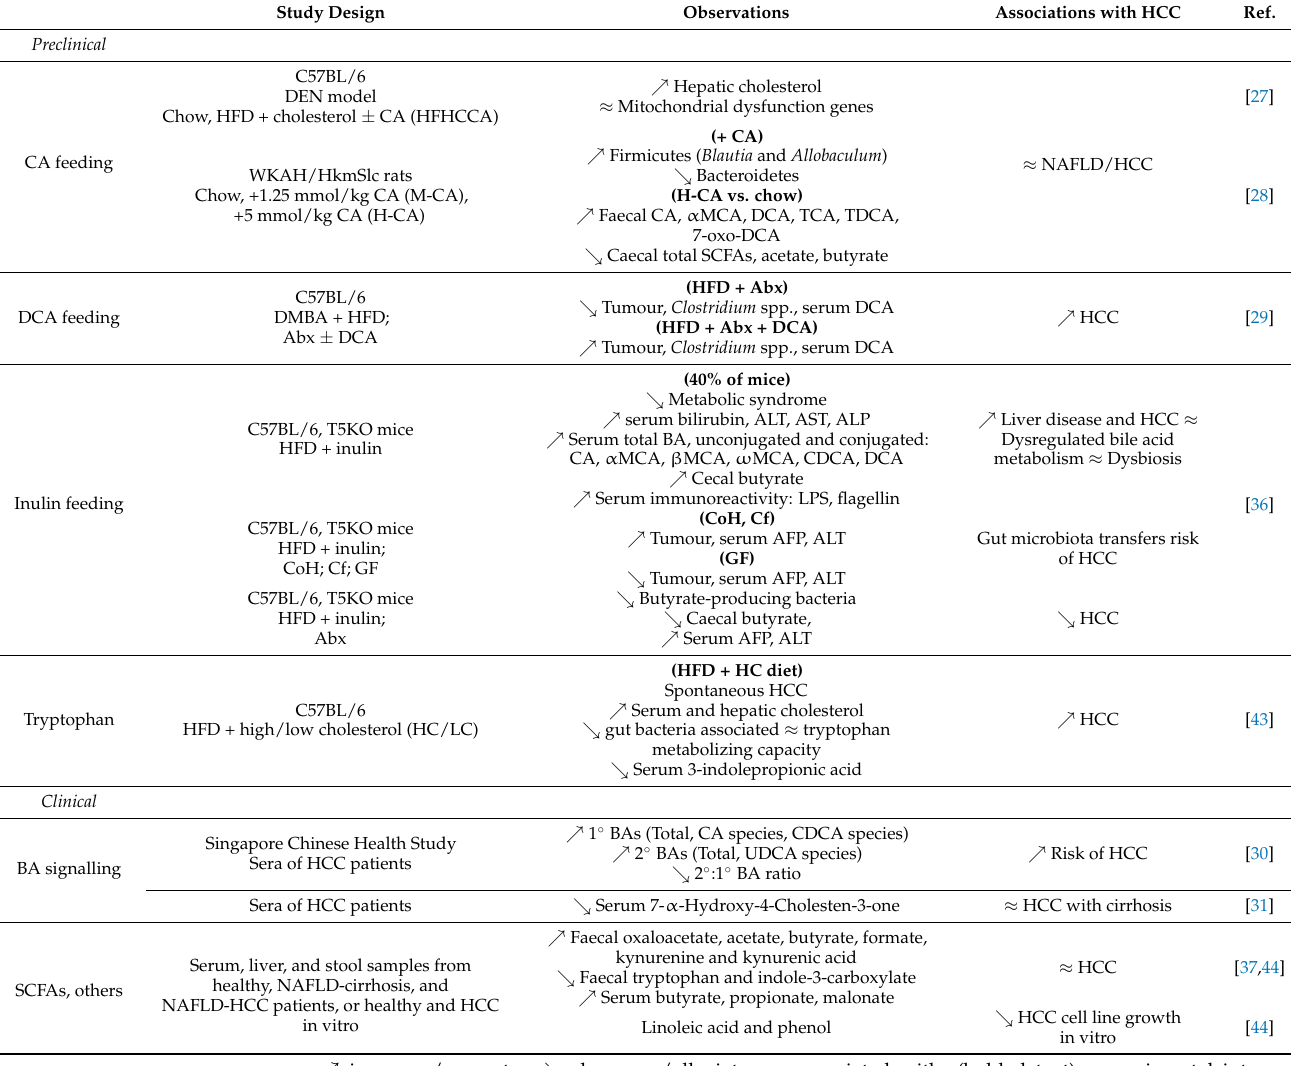
Table 1. Preclinical and clinical associations between metabolites and